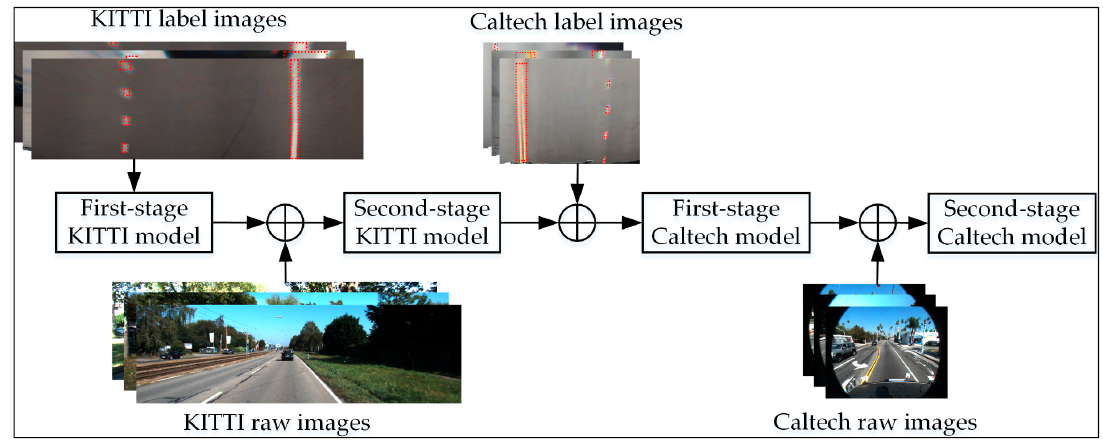
Figure 3. Training flowchart.